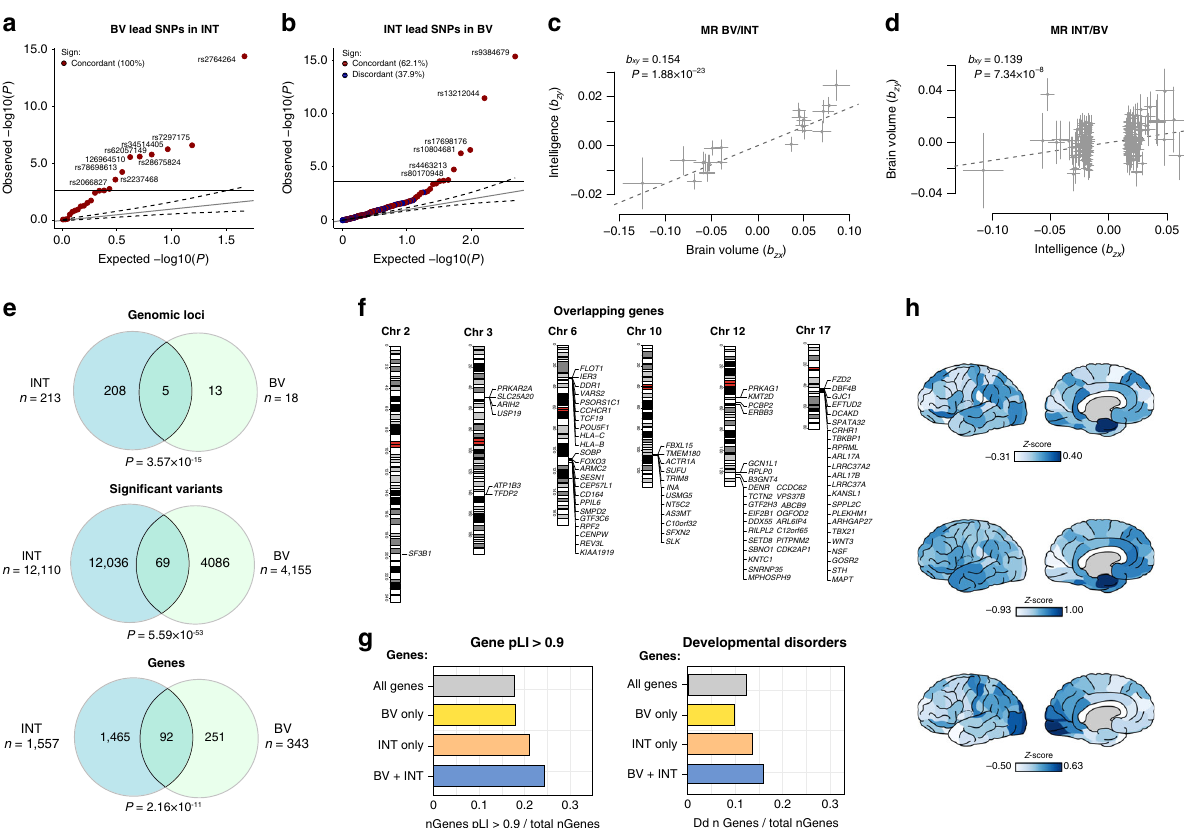
Fig. 3 Analyses of the genetic overlap between brain volume and intelligence. a Q-Q plot showing the observed and expected P- value distribution of 24 lead variants of the brain volume (BV) meta-analysis in intelligence (INT) and b 243 intelligence meta-analysis lead variants in BV. The colors denote the concordance (/discordance) of effects between the two traits. c Mendelian Randomization analysis, showing the effect size and standard errors of each variant of BV ( b zy ) on intelligence ( b zx ) and the diagonal line showing the estimated causal effect ( b xy ) of BV on intelligence. d Similar to ( c ) but of intelligence on BV. e Venn diagrams showing the number of overlapping loci, signi fi cant variants, and genes implicated in BV and intelligence by FUMA and MAGMA. f Karyogram showing the genomic position of the 92 genes that were implicated in the GWAS of both BV and intelligence. g Comparison of the pLI score (representing tolerance to loss-of-function variants) and fraction of genes involved in developmental disorders (DECIPHER database) between BV-only genes, intelligence-only genes (INT), genes associated to both traits (BV + INT), and all genes. h Cortical gene expression patterns (darker colors indicate higher rank scores) across 57 cortical areas of the 92 genes that overlap between BV and intelligence (top panel), and the two clusters of genes (middle and bottom